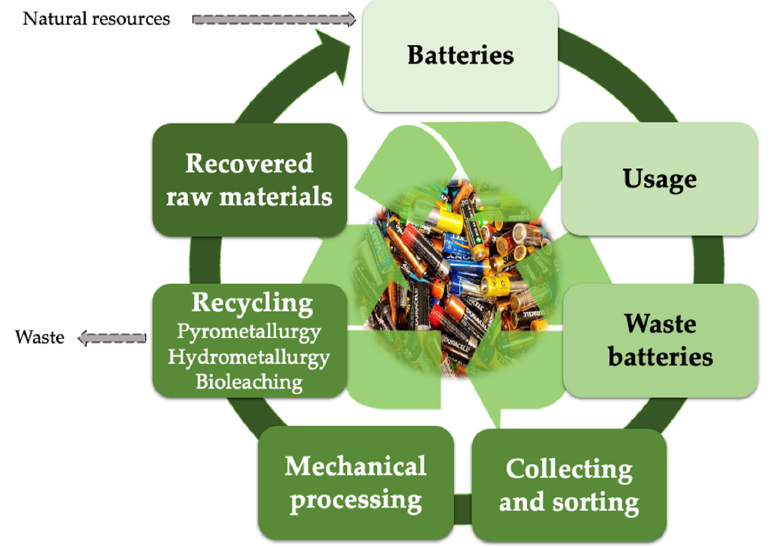
Figure 1. The closed-loop system in batteries and their waste management.